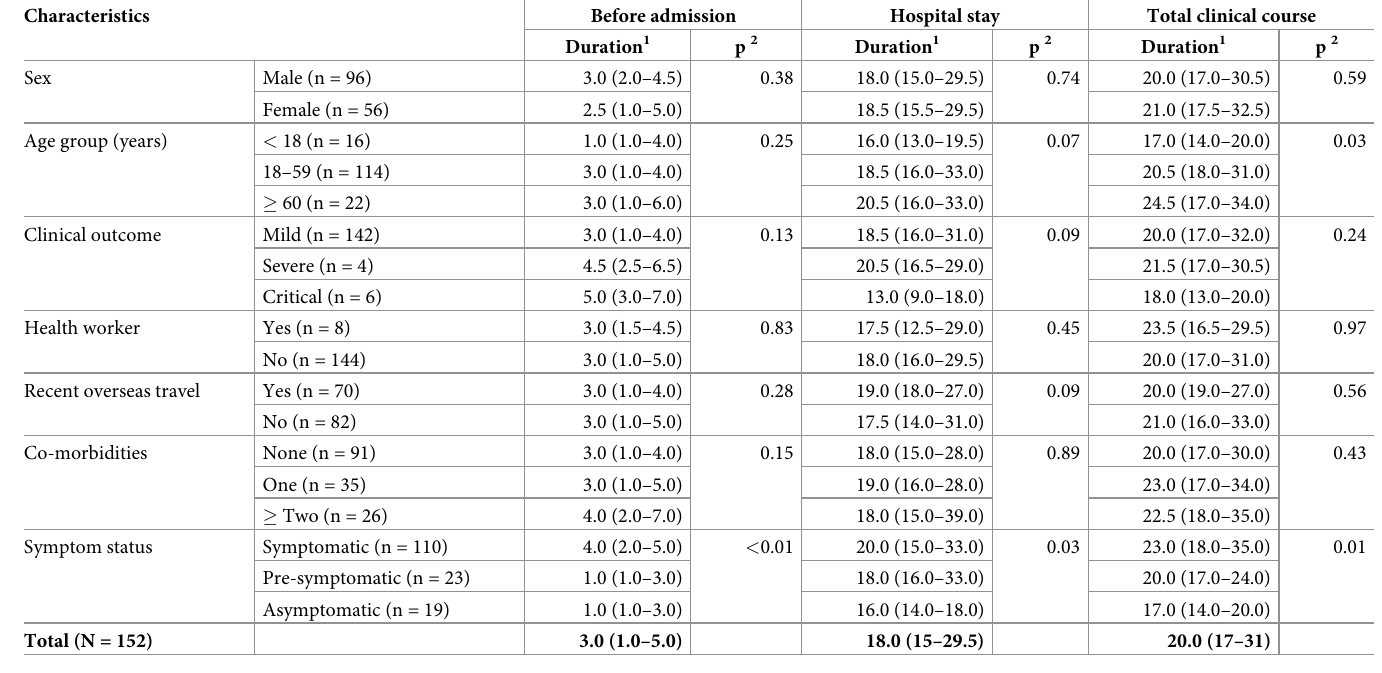
Table 2. Duration of the clinical course of patients by patient and disease characteristics.